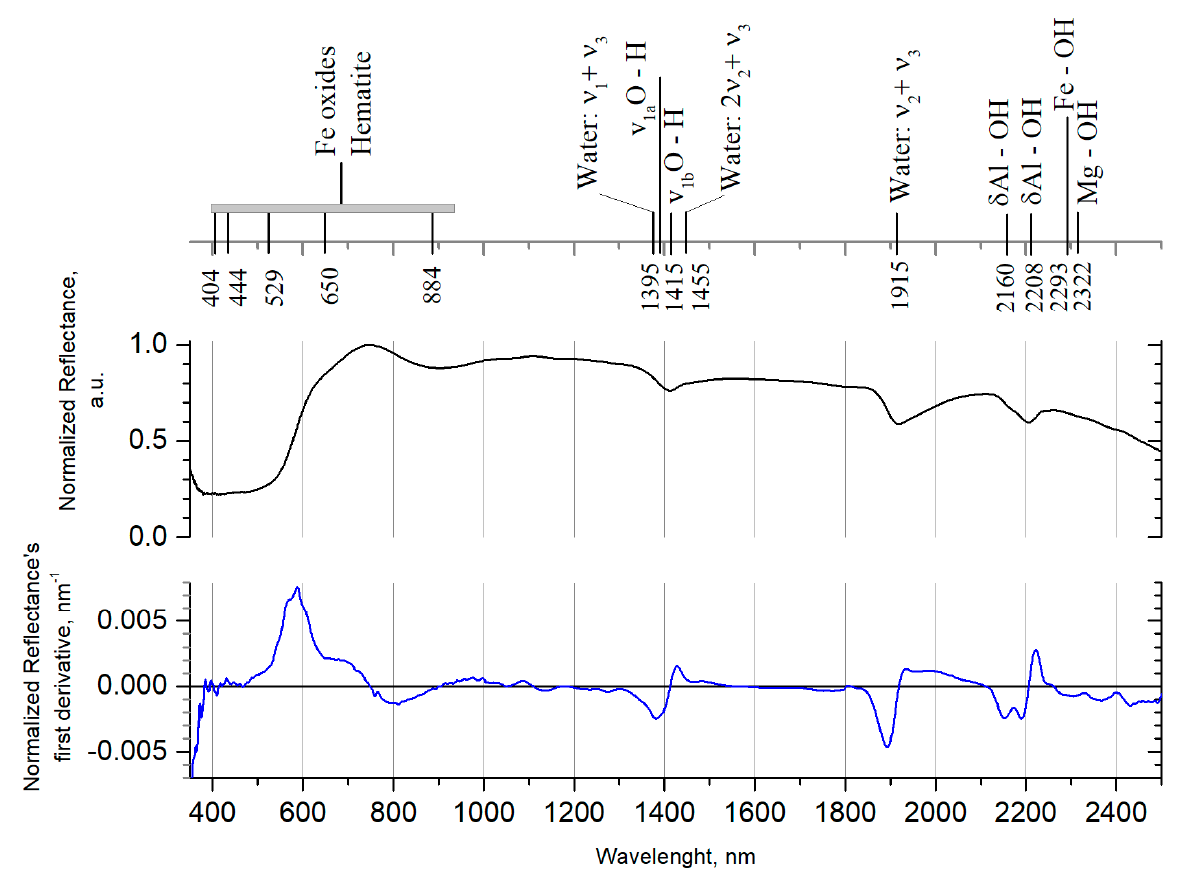
Figure 3. The red clay diffuse reflectance spectrum and its first derivative.